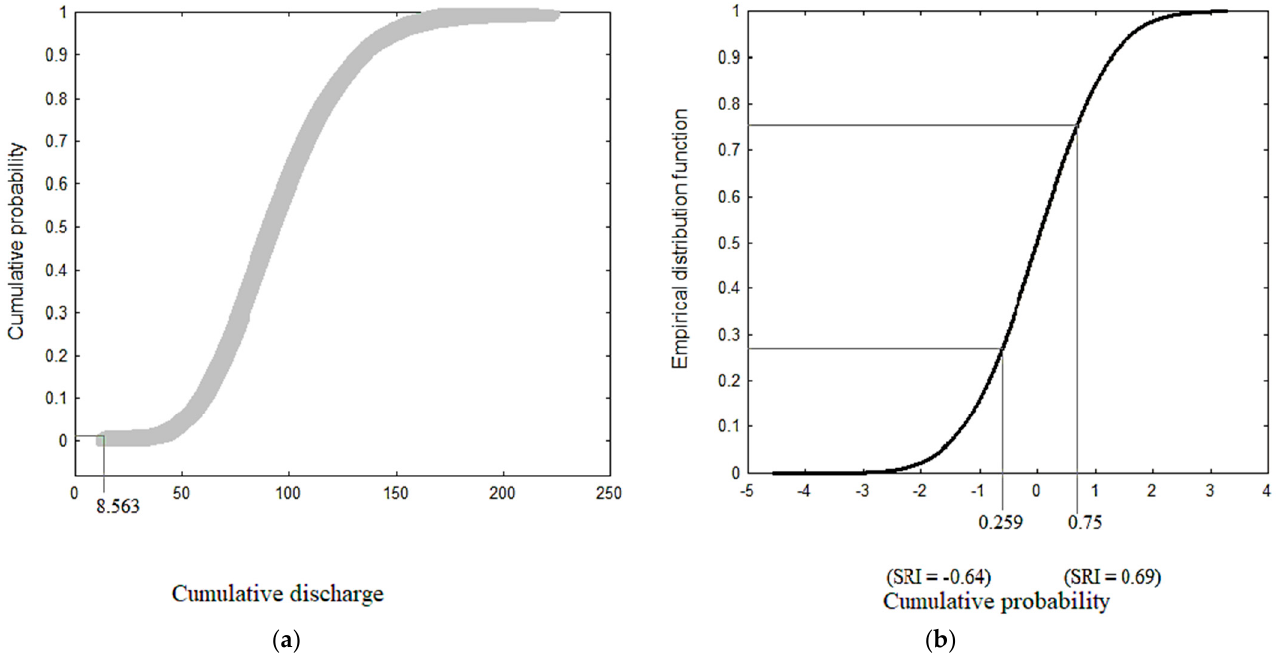
Figure 2. Representation of some steps required to obtain a confidence (a) cumulative distributions function (b) the empirical cumulative distribution function.